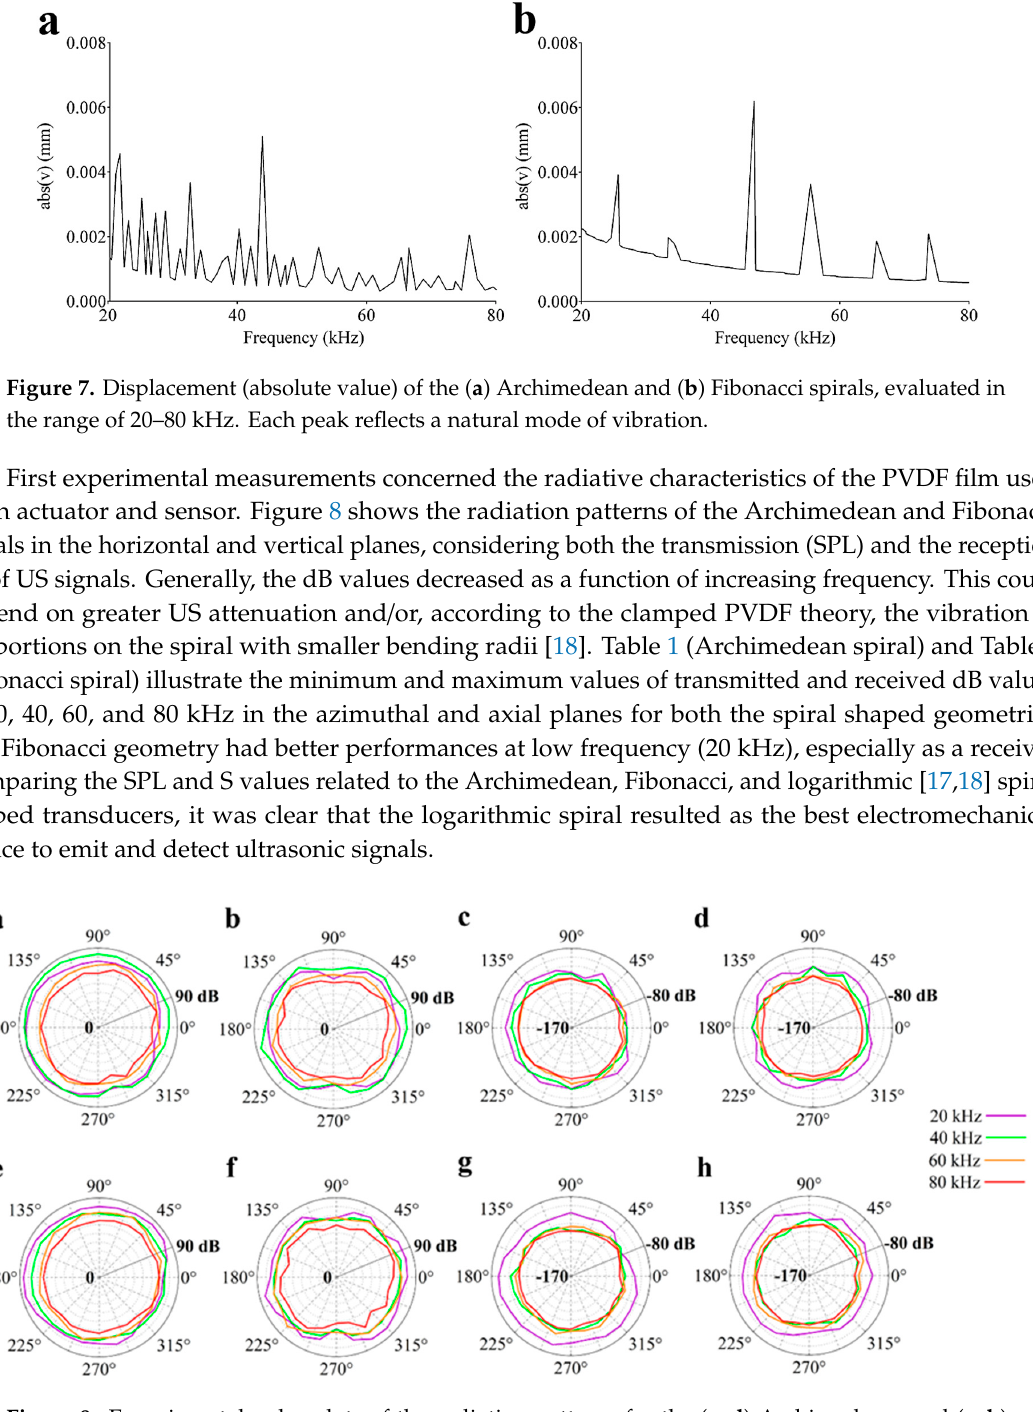
Figure 8. Experimental polar plots of the radiation patterns for the ( a – d ) Archimedean- and ( e – h ) Fibonacci-shaped transducers used as ( a,b,e,f ) transmitters and ( c,d,g,h ) receivers in both the ( a,c,e,g ) horizontal and ( b,d,f,h ) vertical planes.